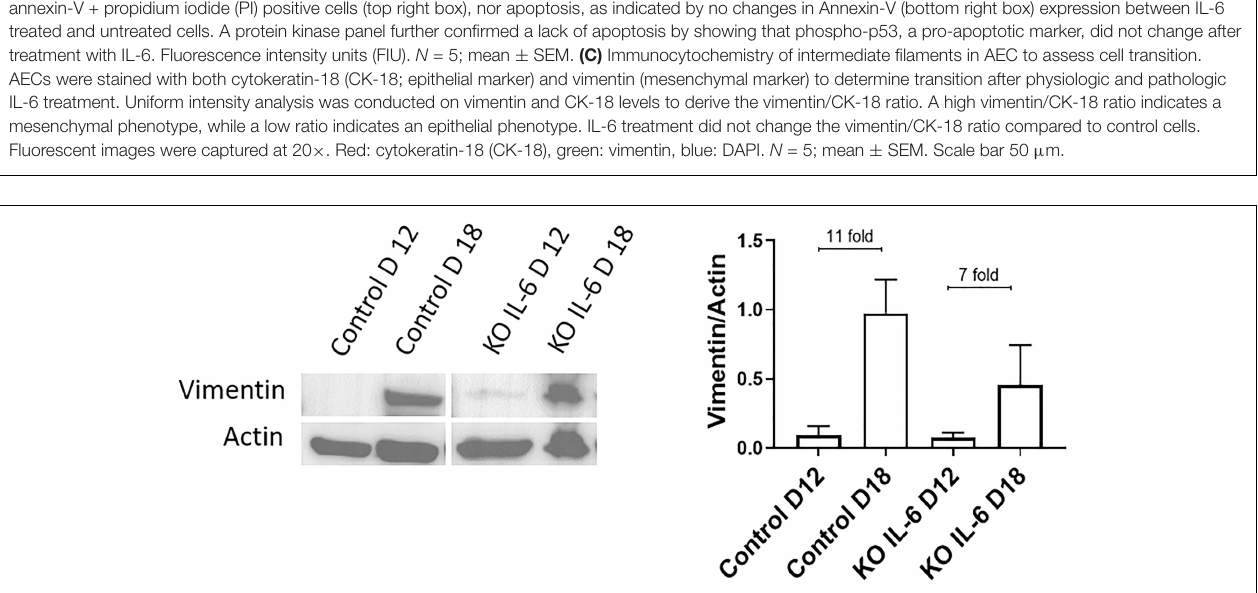
FIGURE 5 | Normal and IL-6 KO mice undergo EMT associated changes at term. Western blot analysis and densitometry of mesenchymal marker vimentin in the amniotic sac of C57B/6 mice and KO IL-6 mice on day 12 (mid-gestation) and day 18 (term) of gestation. Amniotic sacs from control C57B/6 mice showed an increase in vimentin on day 18 compared to day 12 (11-fold), as previously document in CD1 models. The absence of IL-6 did not inhibit the increase in vimentin on day 18 compared to day 12 (7-fold). N = 3 for each category; mean ±